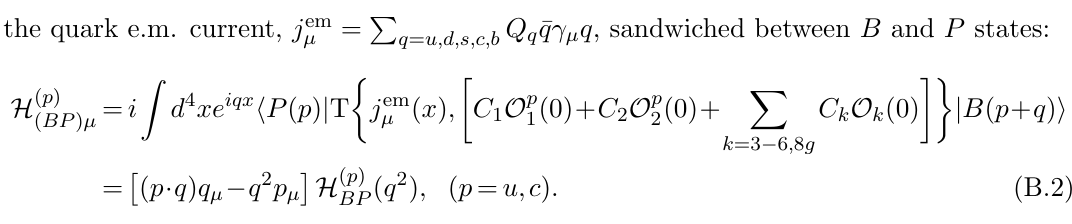
( q 2 ) and H ( c ) ( q 2 ) in (cid:22) B s ! K 0 ‘ + ‘ (cid:0) B s K B s K